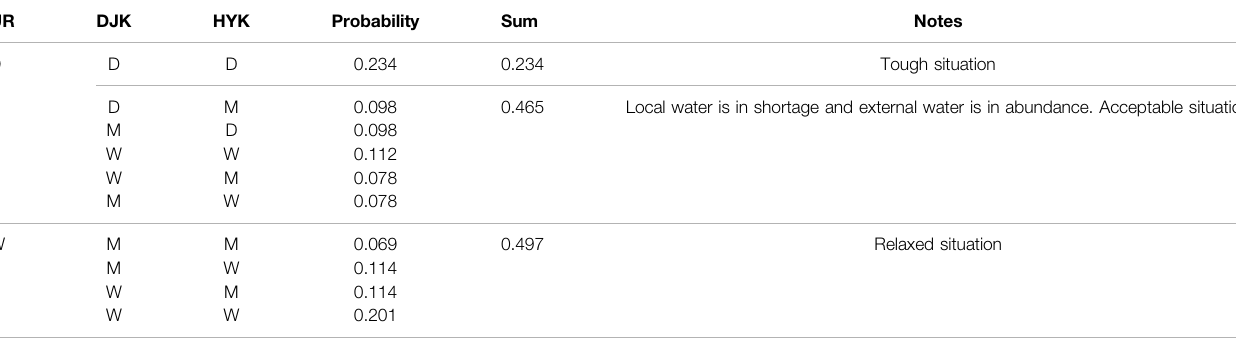
TABLE 8 | Conditional encounter